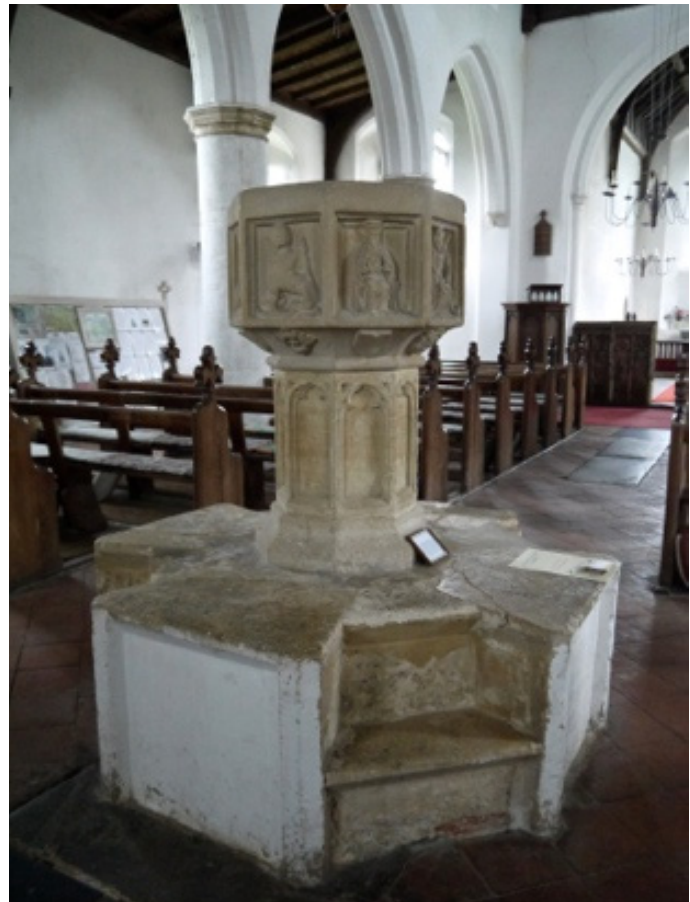
Figure 7. The font at All Saints Morston.